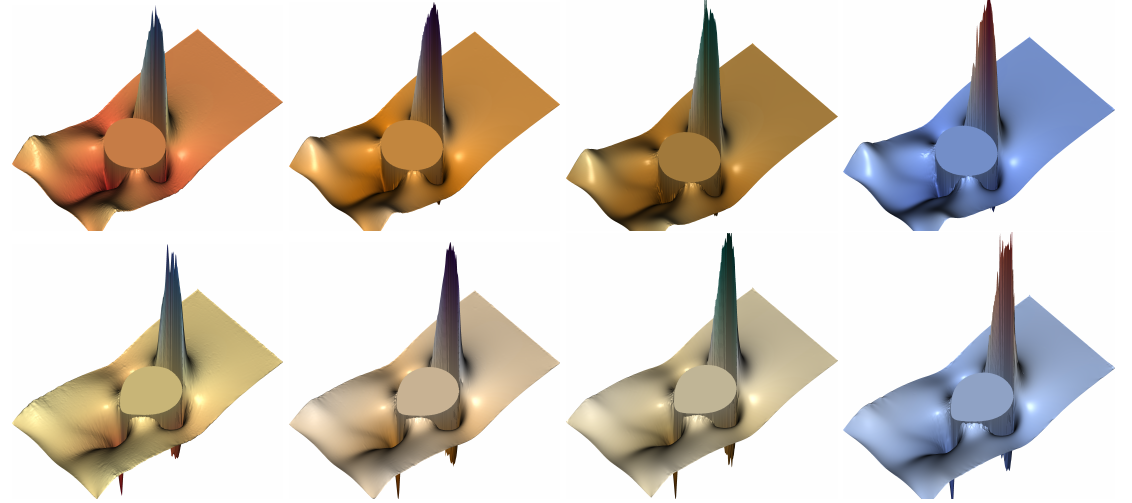
Figure 11. Representation of the normal stress difference of the polymer stress tensor, τ p ,11 − τ p ,22 , for the FENE model ( b = 50) with c = 5, De = 3, at dimensionless instants of time t = 2 and t = 3, for variable types of CSRBF. From left to right: ϕ 3,0 , ϕ 3,1 , ϕ 3,2 , ϕ 3,3 . Top row: t = 2; bottom row: t = 3.